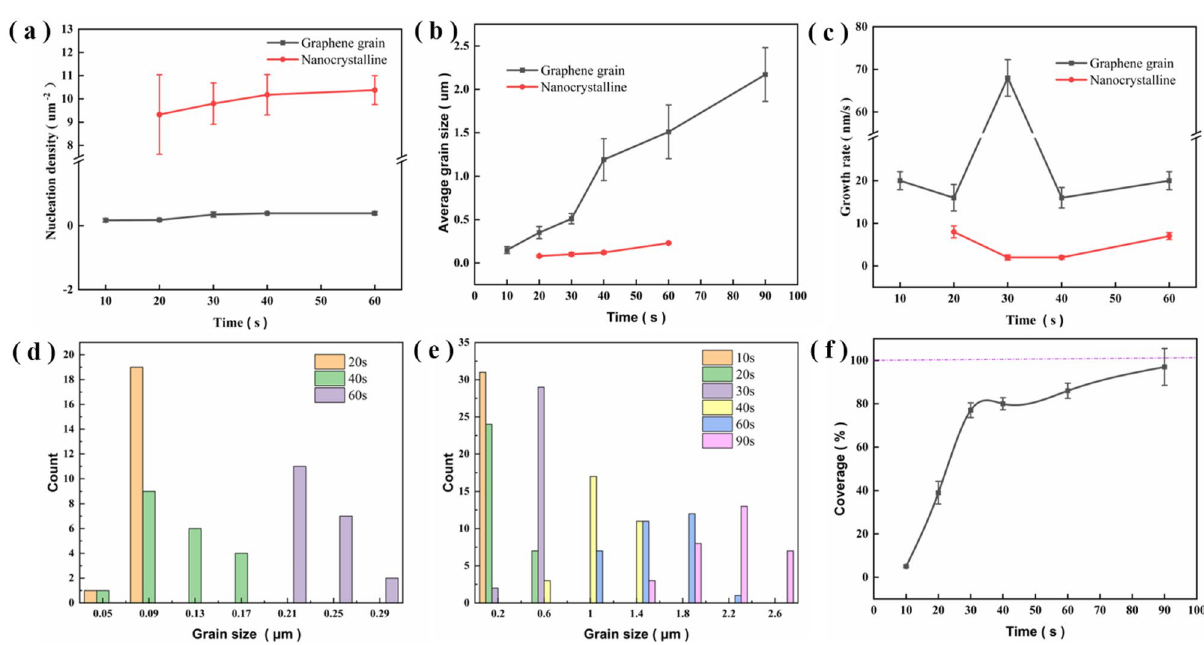
Figure 6. Time evolution of ( a ) the graphene nucleation density and ( b ) average grain size at 850 °C in PECVD. ( c ) Grain growth rate of graphene. The black line represents larger graphene grains, and the red line represents nanocrystalline graphene. Distribution of ( d ) nanocrystalline graphene and ( e ) graphene grains with the growth time. ( f ) Coverage of graphene grown on Cu with the growth